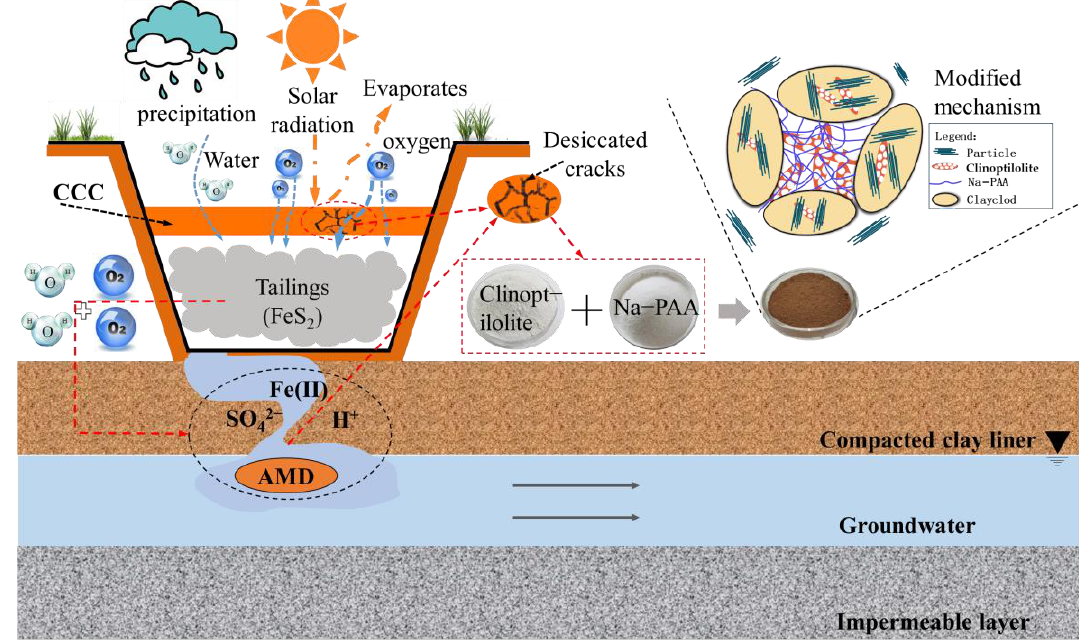
Figure 2. Problems to be solved and research approach.